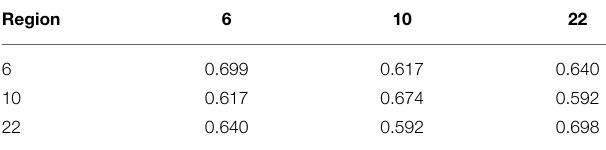
TABLE 1 | CP similarities for different classifications using the Pearson coefficient in the regions numbered 6, 10, and 22 in Figure 1.